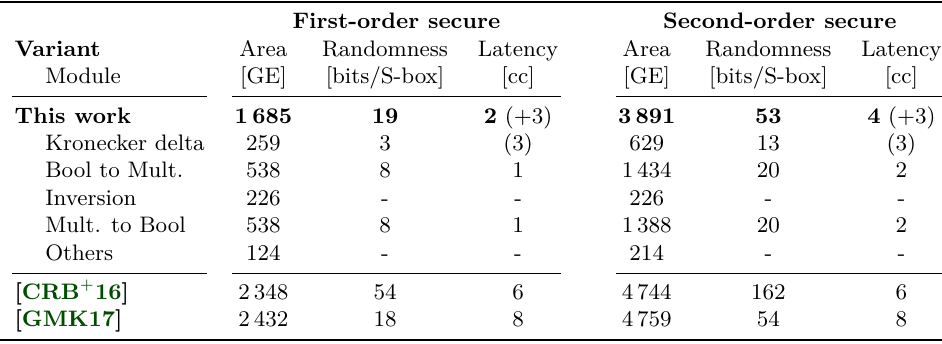
Table 4: Implementation results for the AES S-box with Nangate 45nm Library First-order secure Second-order